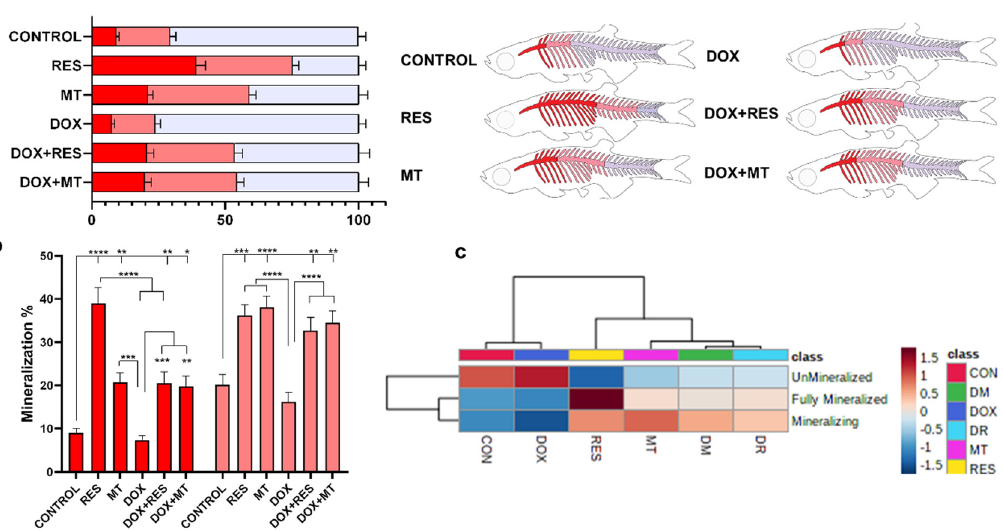
Figure 4. Mineralization of zebrafish vertebral column. Percentage of mineralized (red), mineralizing (pink), unmineralized (blue) vertebrae ( a ) and graphical representation of the mineralization status of the zebrafish. Mineralization status of the vertebrate ( b ), (red represents mineralized vertebrae and pink represents mineralizing vertebrate). Heat map of mineralization of vertebrae of zebrafish feed with resveratrol (RES), MitoTEMPO (MT) and doxorubicin (DOX) supplemented microdiets ( c ). Levels of significance were calculated using Tukey’s multiple comparisons (one-way ANOVA) [* p ≤ 0.05, ** p ≤ 0.01, *** p ≤ 0.001, **** p ≤ 0.0001] [N = 20 × 4].